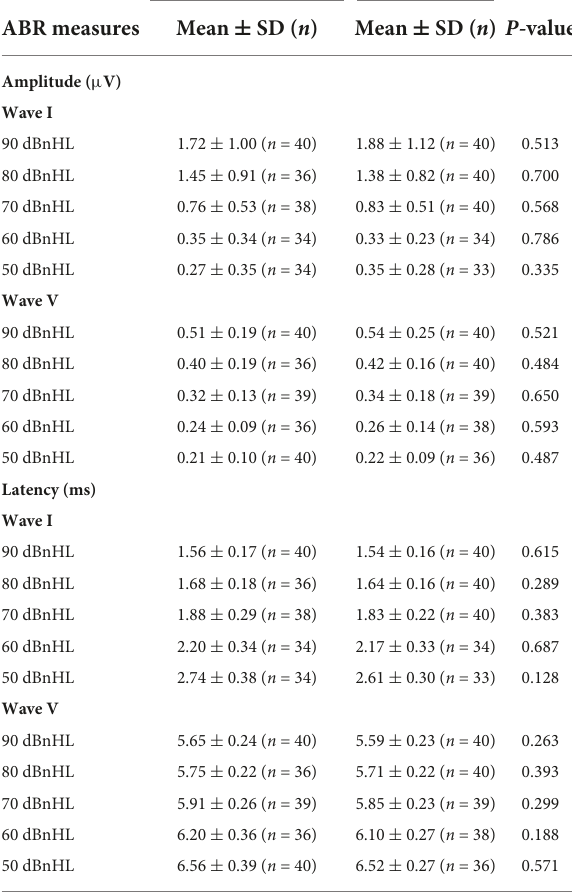
TABLE 1 Mean, standard deviation, and group comparisons for ABR wave I and wave V variables (amplitude and latency). Noise-exposed group Control